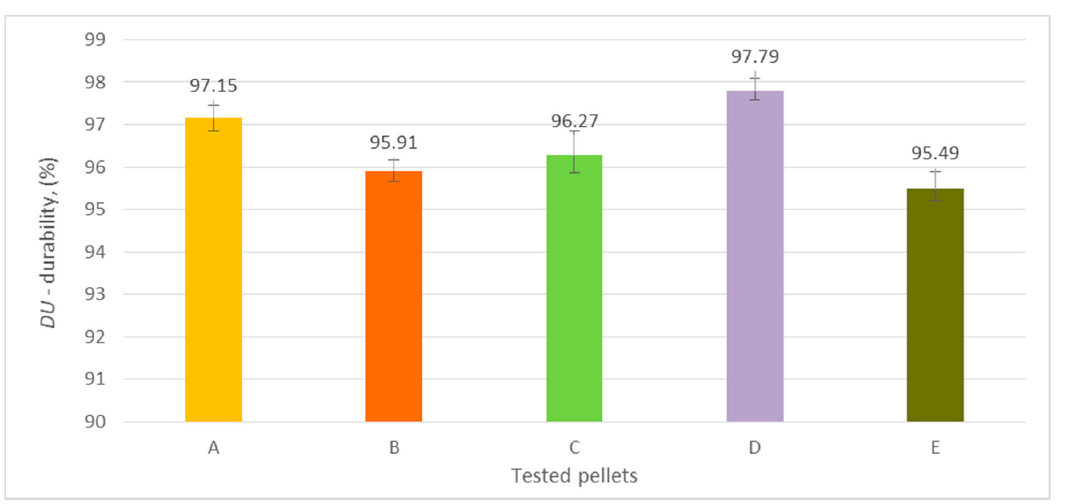
Figure 8. Durability tests results for tested pellets according to EN ISO 17831 (own study).